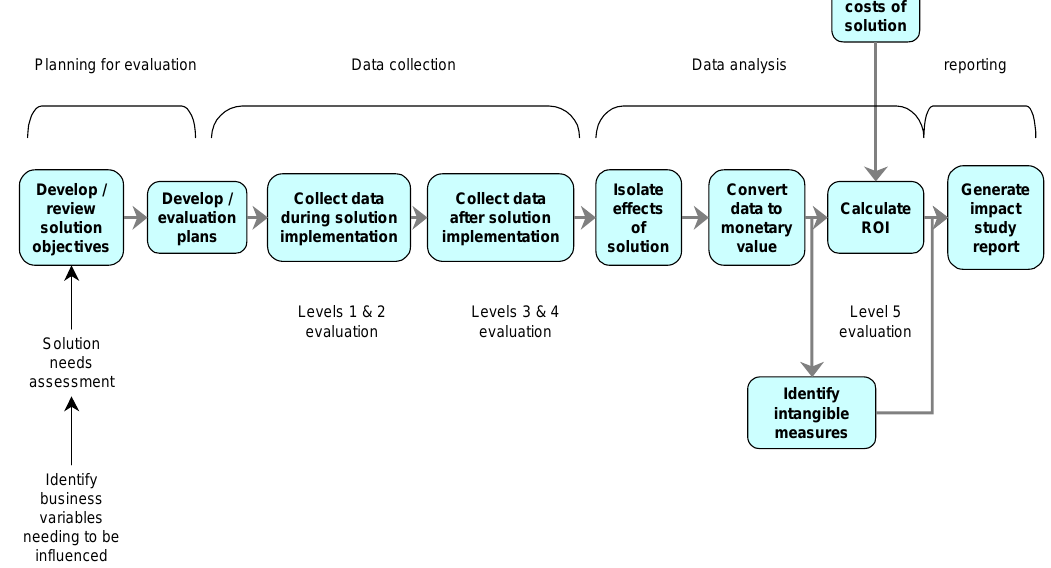
Figure 2: Phillips’ model for the calculation of ROI for an HR intervention Source: Phillips,